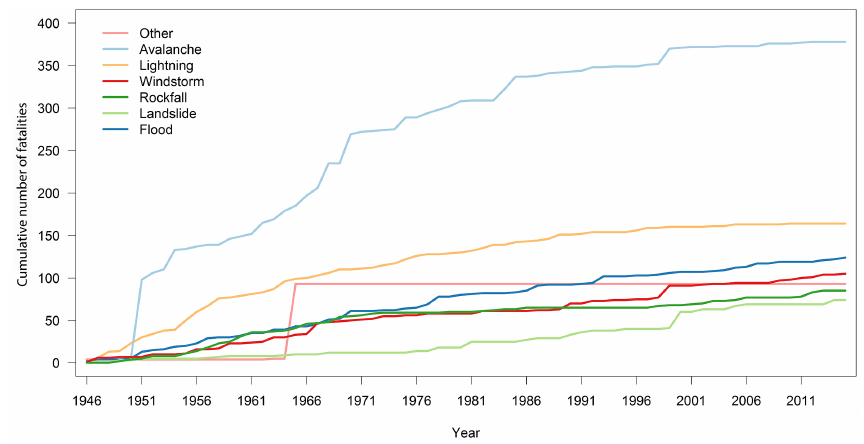
Figure 4. Cumulative plot of the number of natural hazard deaths in Switzerland from 1946 to 2015 for the different natural hazard categories considered in this